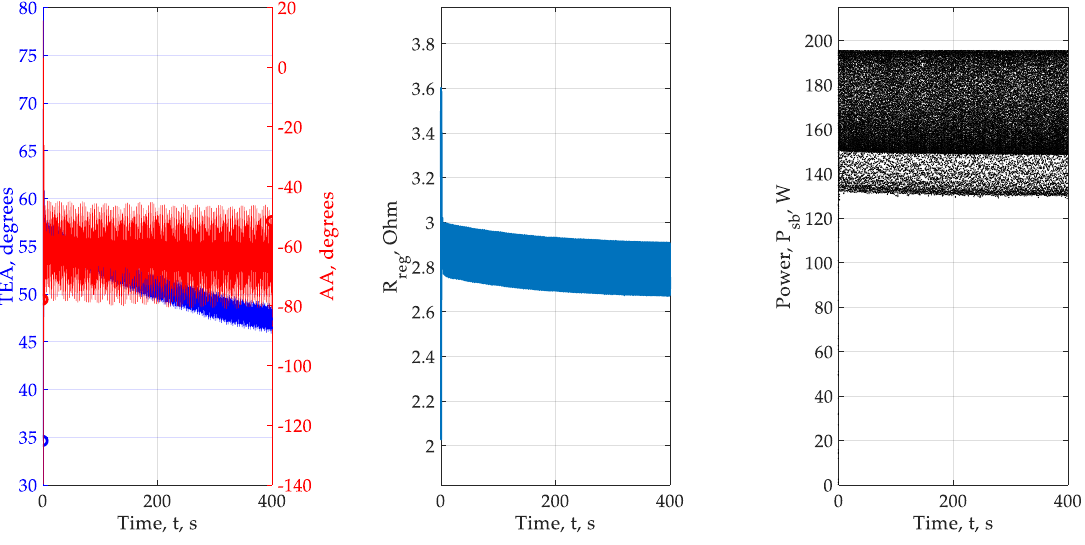
Figure 14. Experiment No.5 — Cubas, 2014.